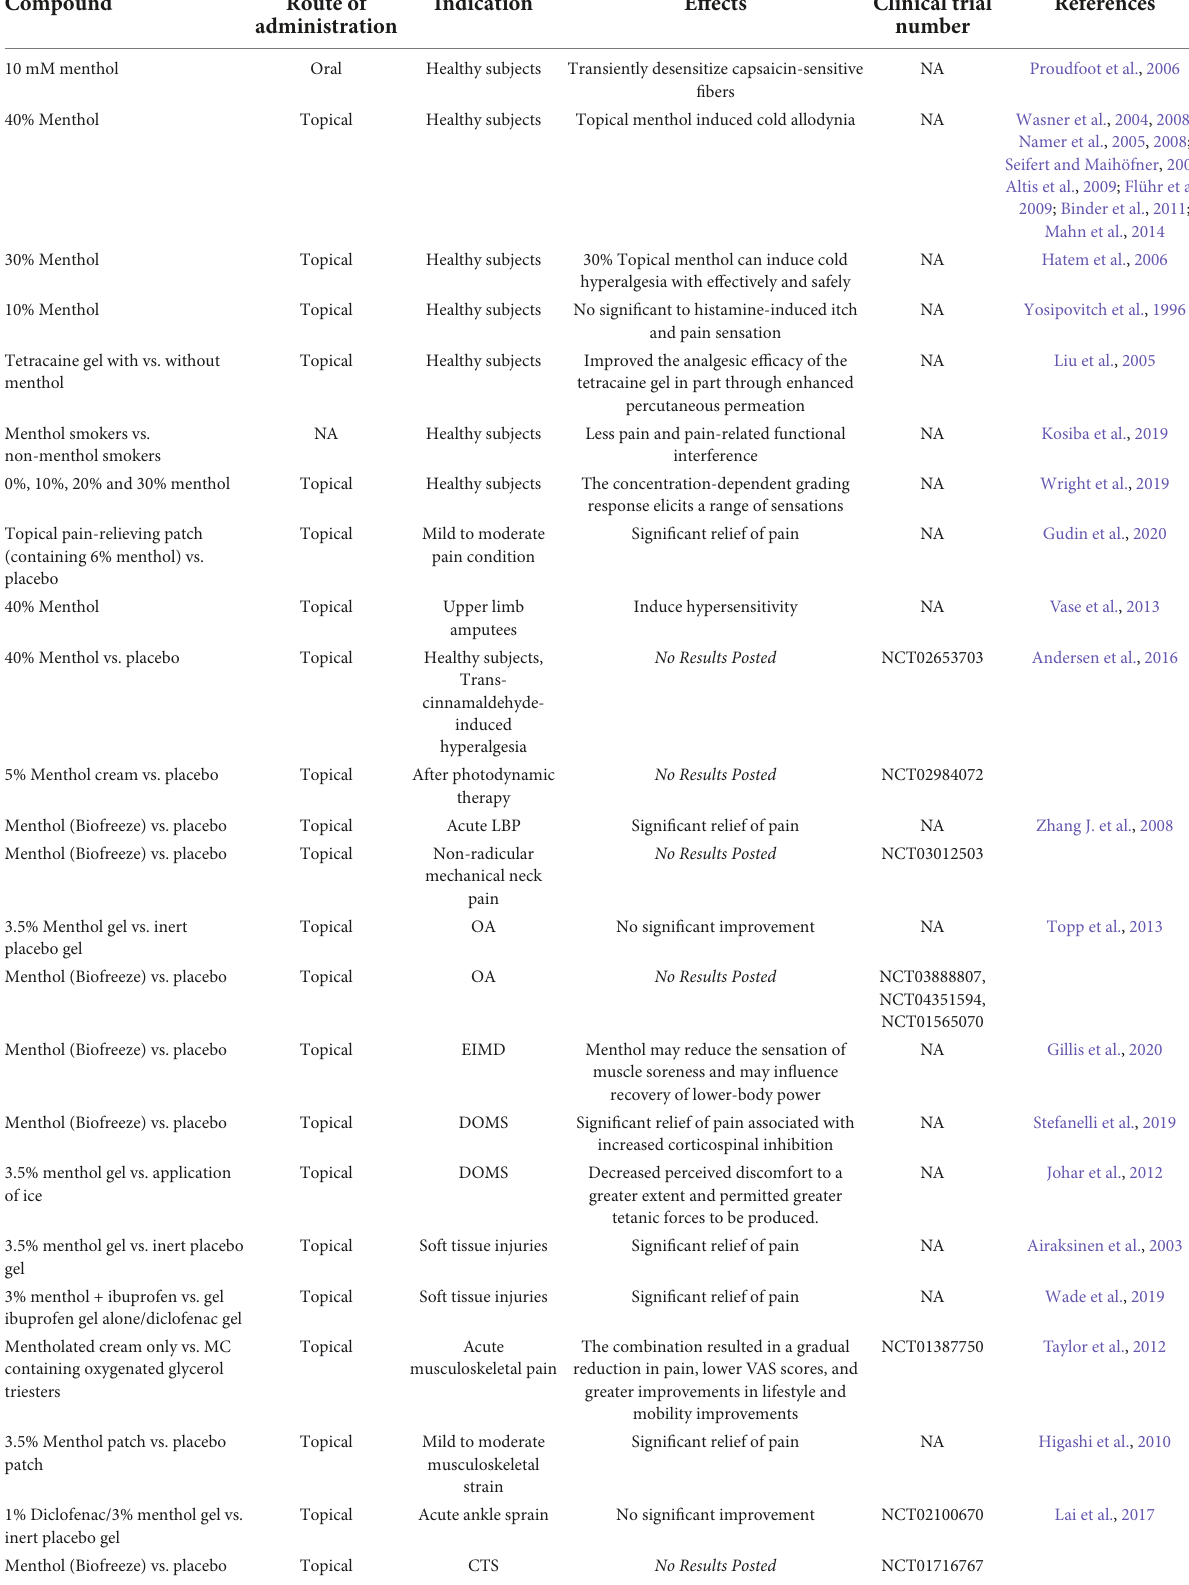
TABLE 2 Human models of menthol and its